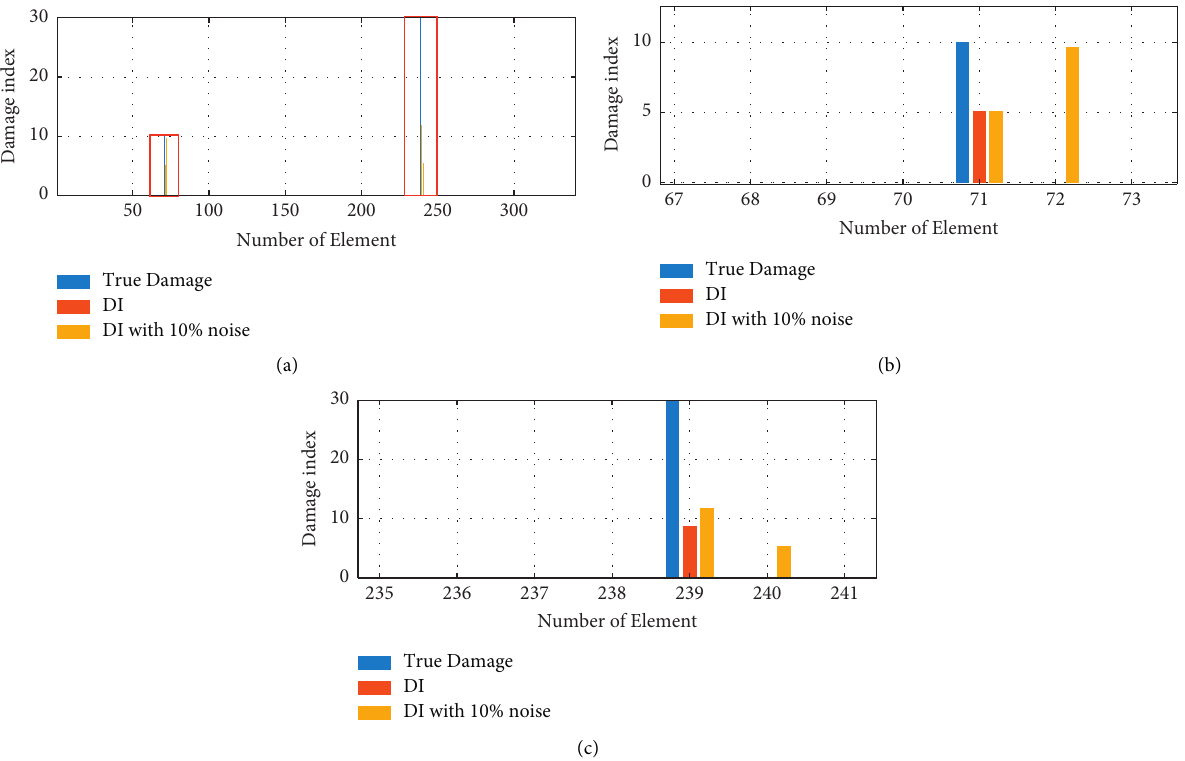
Figure 18: Results of multiple-damage scenario D5 containing 10% measurement noise. (a) Original result. (b) Zoomed result part 1. (c) Zoomed result part 2.